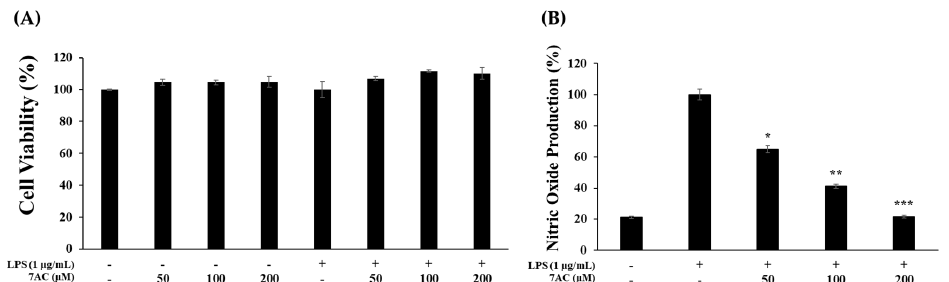
Figure 2. Effects of 7AC on cell viability and nitric oxide production in lipopolysaccharide (LPS)- stimulated RAW 264.7 cells. ( A ) Cell viability was assessed in cells that were not stimulated or stimulated with LPS (1 µ g / mL) in the present of 7AC for 24 h; ( B ) nitric oxide (NO) production experiments. * p < 0.05, ** p < 0.01, *** p < 0.005 versus LPS alone.